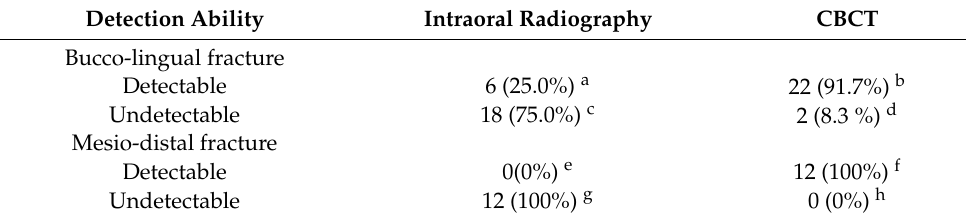
Table 4. Detection ability of vertical root